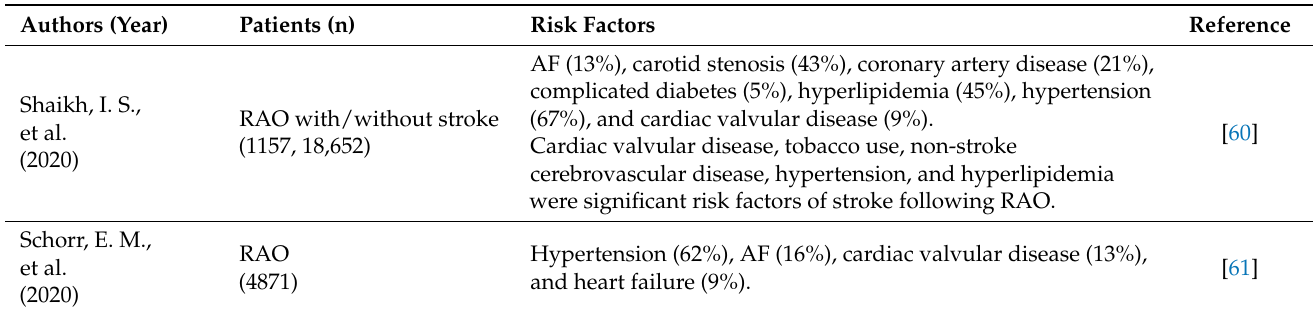
Table 1. Clinical studies published between 2020 and 2022 that evaluated the association with cardiovascular